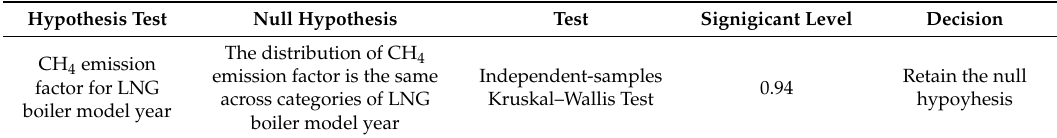
Table 7. The result of Kruskal–Wallis test by CH 4 emission factor for LNG boiler model